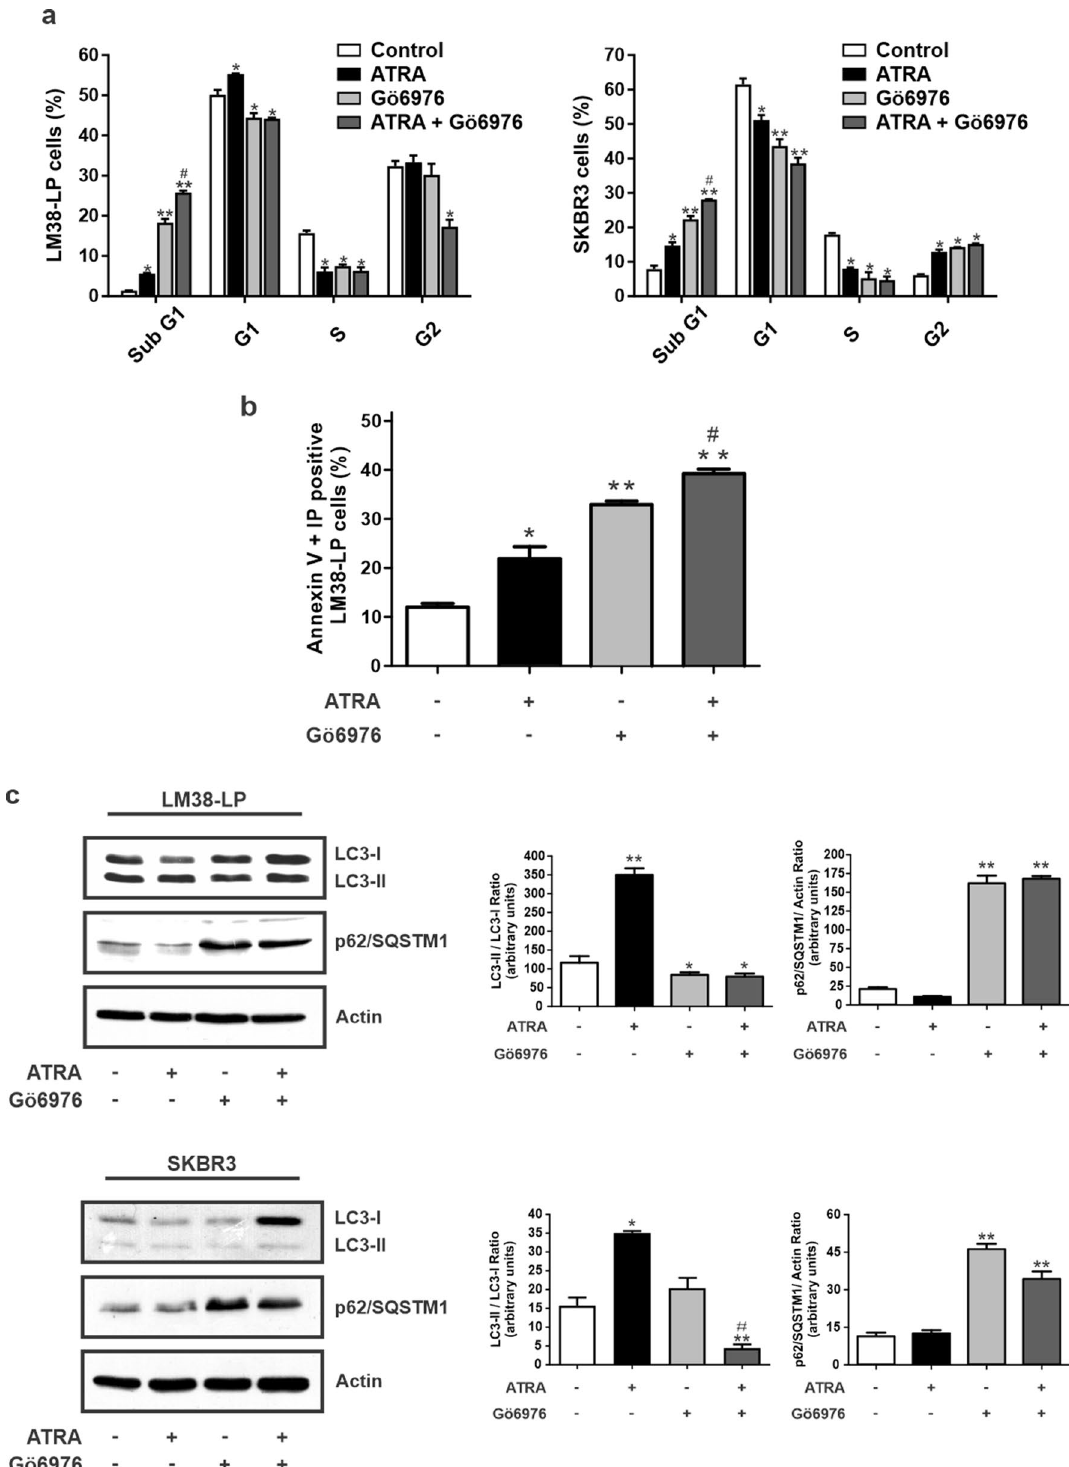
Figure 3. Modulation of cell cycle progression, apoptosis and autophagy. ( a ) Analysis of LM38-LP and SKBR3 cell cycle by flow cytometry after treatments with ATRA (0.5 µM) and/or Gö6976 (0.5 µM) or vehicle as control for 96 h. Histograms represent the mean ± S.D., * p < 0.05 versus control, ** p < 0.01 versus control, # p < 0.05 versus Gö6976 and ATRA (ANOVA test). Three independent experiments were performed. ( b ) Quantification of Annexin V staining by flow cytometry. LM38-LP cells were treated with ATRA (0.5 µM) and/or Gö6976 (0.5 µM) or vehicle as control for 96 h. Data represent the mean ± S.D, * p < 0.05 versus control, ** p < 0.01 versus control, # p < 0.05 versus Gö6976 and ATRA (ANOVA test). Three independent experiments were performed. ( c ) Immunoblot analysis and quantification of LC3 II/LC3 I and p62/SQSTM1 for LM38-LP and SKBR3 cells pre-treated with ATRA (0.5 µM) and/ or Gö6976 (0.5 µM) or vehicle as control during 48 h. Results are representative of 3 independent experiments. Histograms represent mean ± S.D. of triplicate determinations, * p < 0.05 versus control, ** p < 0.01 versus control, # p < 0.05 versus Gö6976 and ATRA (ANOVA